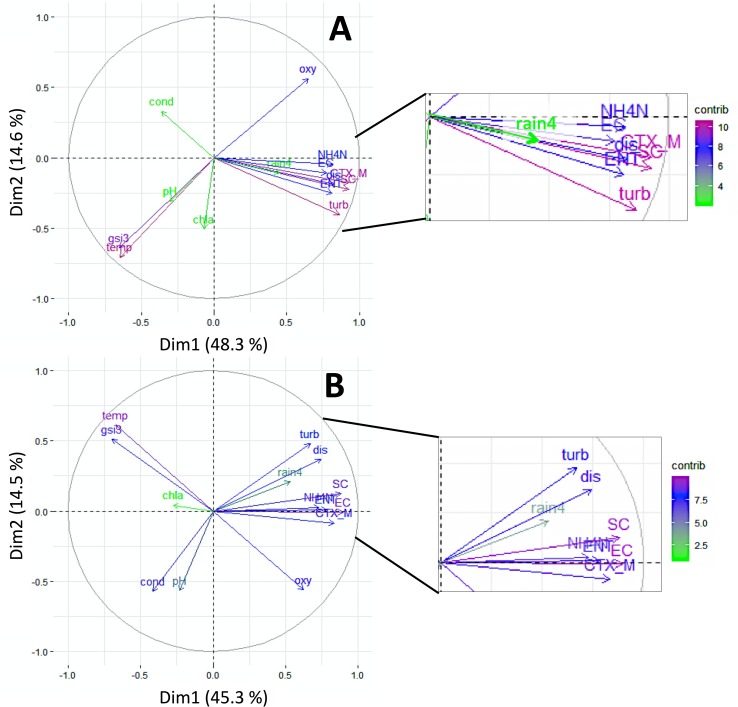
PCA biplot of blaCTX-M genes, FIO and environmental parameters with correlation circle and contributions indicated by color gradient.Data are shown individually for (A) site 1 and (B) site 2 (Abbreviations: rain4: 4-day-sum of rainfall; temp: water temperature; cond: conductivity; gsi3: 3-day-sum of global solar irradiance; chla: chlorophyll-a; dis: discharge; CTX_M: blaCTX_M genes; EC: E. coli; ENT: intestinal enterococci; SC: somatic coliphages; turb: turbidity; oxy: oxygen content; NH4N: ammonium-nitrogen; contrib: contribution).